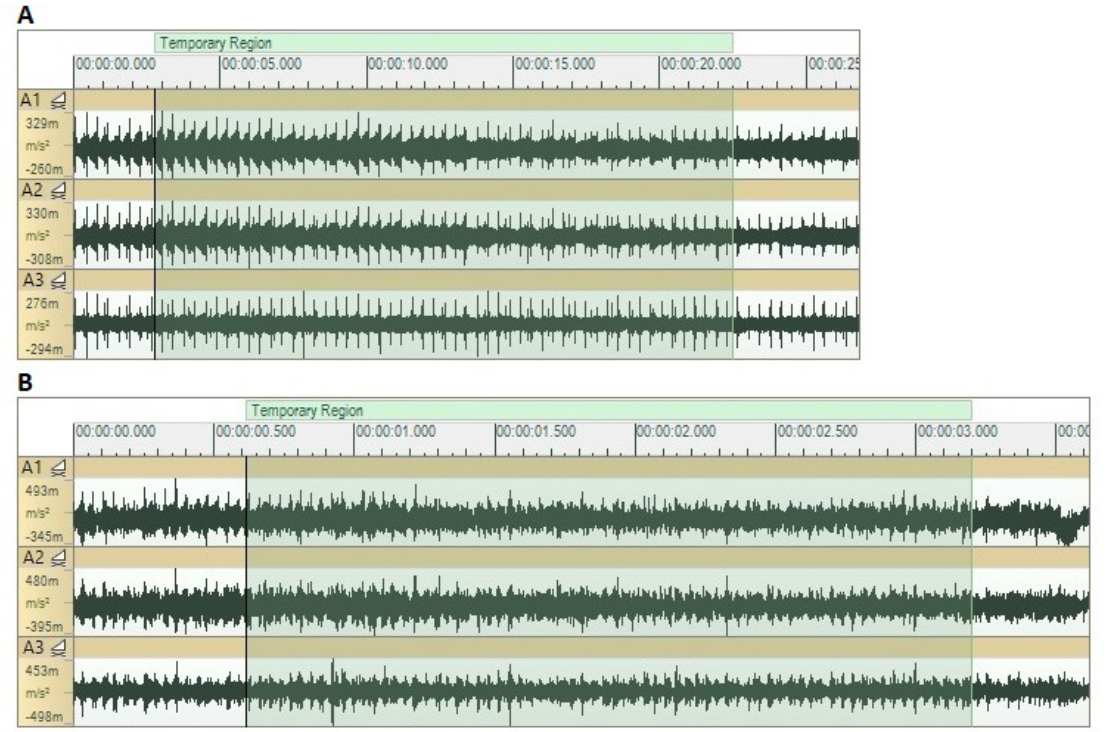
Figure 7. Signals measured on the workpiece during the UVABB process with a 250-N nominal preload in all three spatial directions. ( A ) 90 mm/min; ( B ) 900 mm/min.